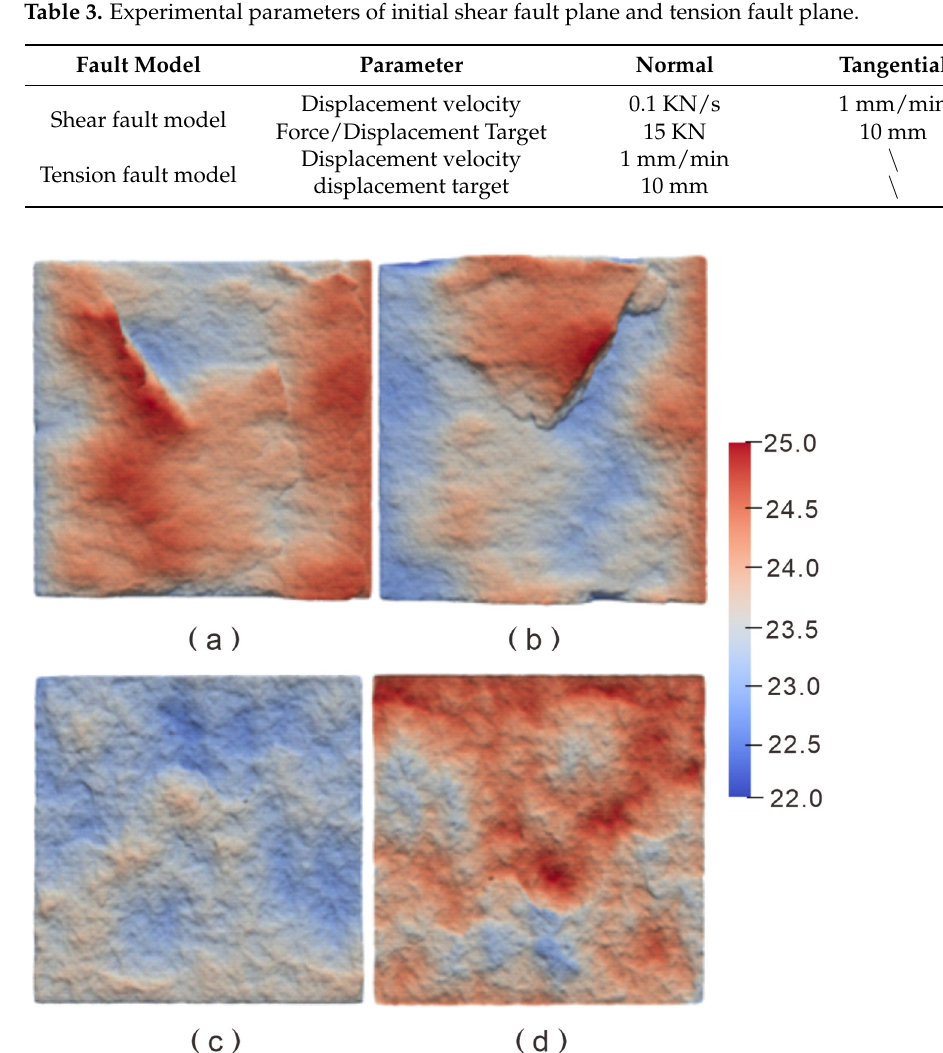
Figure 3. Initial fault plane (( a ) is the upper surface of the shear fault model, ( b ) is the lower surface of the shear fault model, ( c ) is the upper surface of the tensile fault model, ( d ) is the lower surface of the tensile fault model).